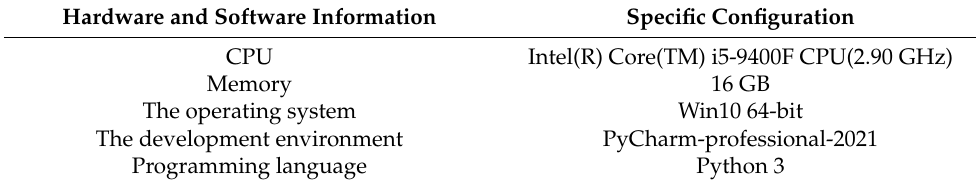
Table 3. Experimental environment information.